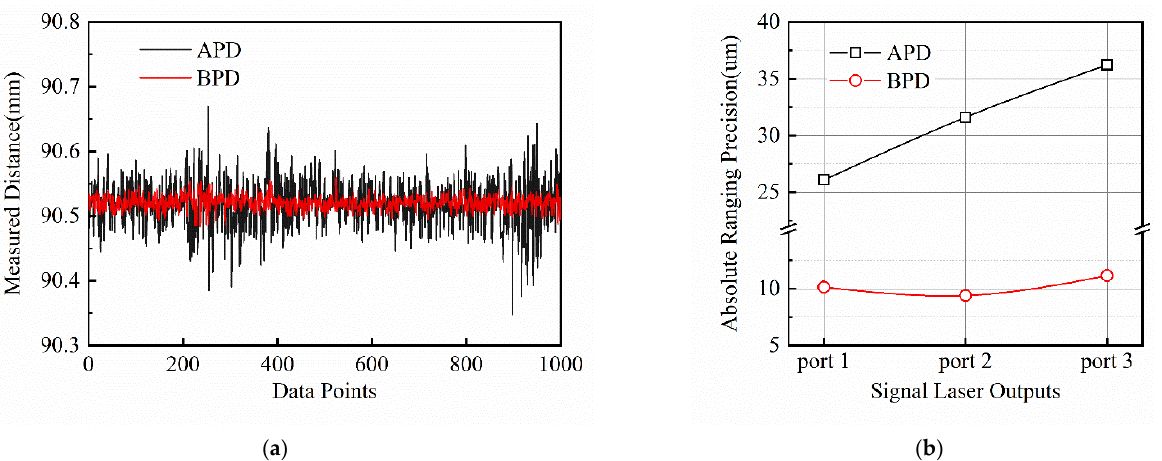
Figure 5. ( a ) Measured distance results in ~0.5 s; ( b ) Absolute ranging precision of the measured distance at a close target-reference separation.